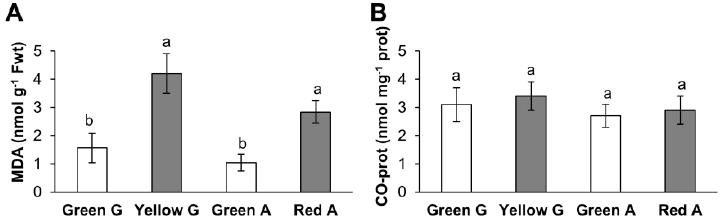
Figure 1. ( A ) Lipid peroxidation (malondialdehyde MDA content) and ( B ) carbonyl (CO) protein content in immature green Galena (G), mature yellow Galena, green Alonso (A) and mature red Alonso pepper fruits. Data are means ± standard error (SE) of three technical replicates of at least three biological samples. Di ff erent lower case letters indicate that data are significantly di ff erent according to the Kruskal-Wallis test at p < 0.05.